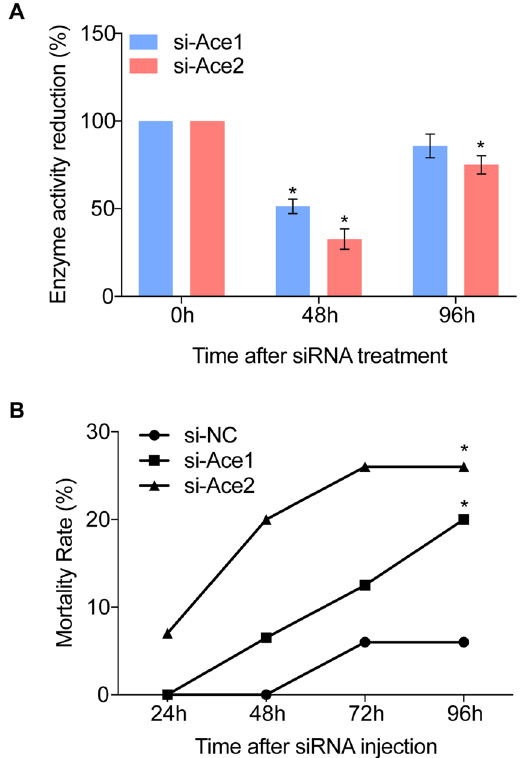
Figure 3. AChE activities and mortality in experimental larvae. Panel A: siRNA treatments led to reduced AChE activities at the indicated times PI. The histogram bars represent mean percent enzyme activity normalized to zero h PI. * Significant difference at P ≤ 0.05. Panel B: Mortality as a function of time PI. At all times after 24 h PI, si BmAce1 - and si BmAce2 -treated silkworms had higher mortalities compared to controls. Each data point indicates mean mortality and the error bars show 1 SEM. The asterisks above the bars indicate significant differences. All experiments were repeated in triplicate, n = 30.